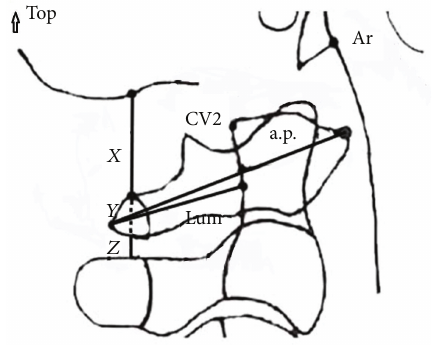
Figure 2: Linear measurements on the first cervical